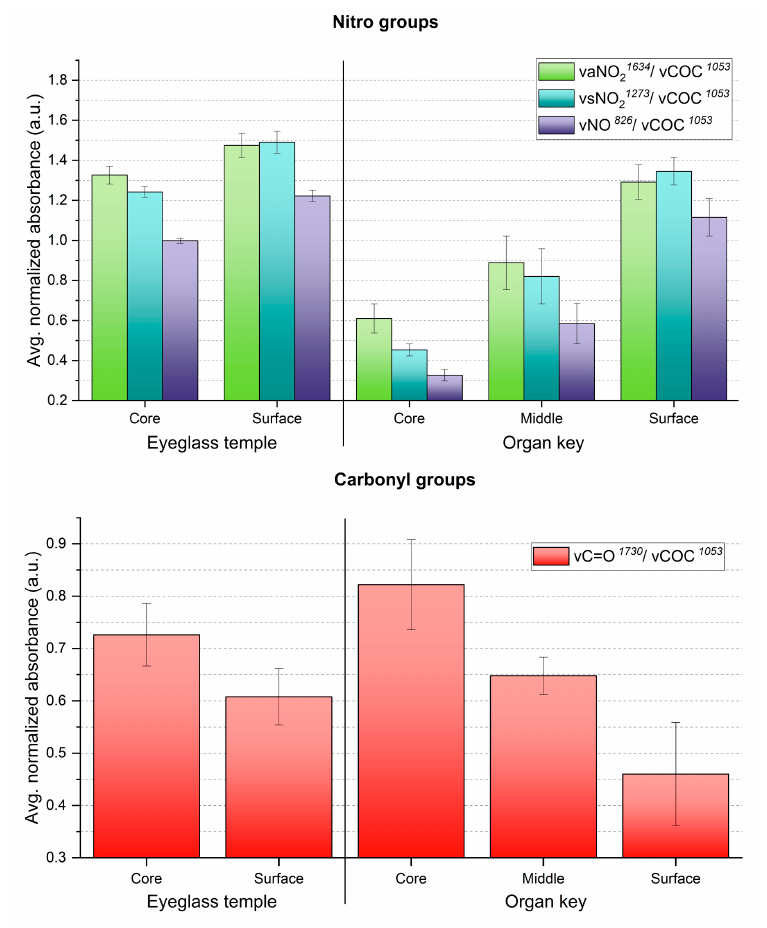
Figure 10. Averaged ATR-FTIR absorbances for NO 2 ( up ) and C=O ( down ) groups of the two naturally aged CN objects. Error bars correspond to the SD.